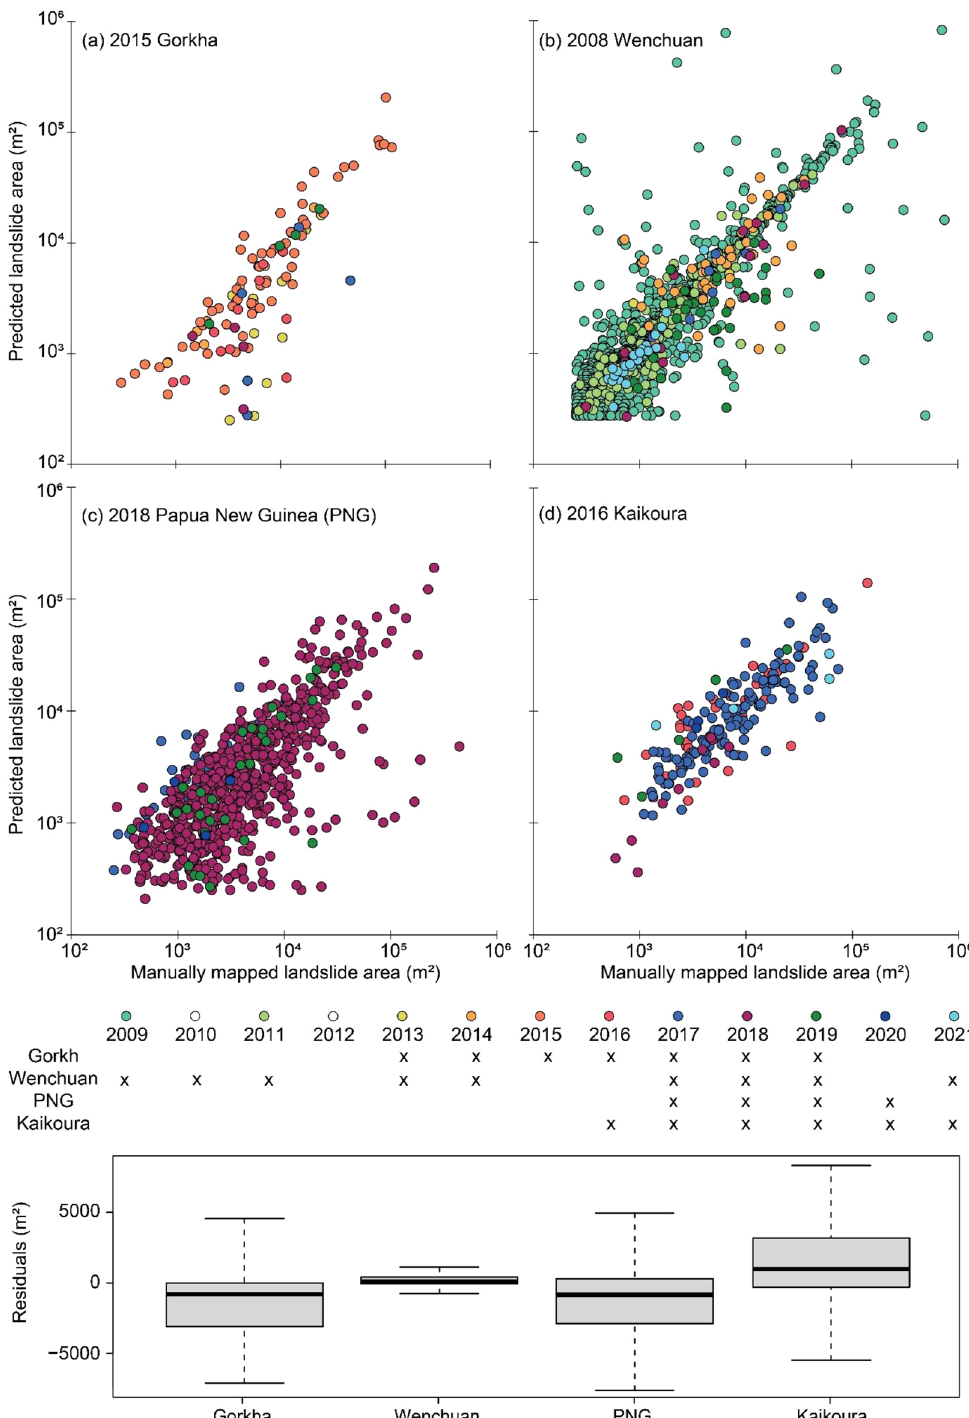
Figure 10. (Upper panel) Difference in area between the predicted landslides versus ground truth landslides. (Lower panel) Residuals measured in m 2 between the ground truth landslides and predicted